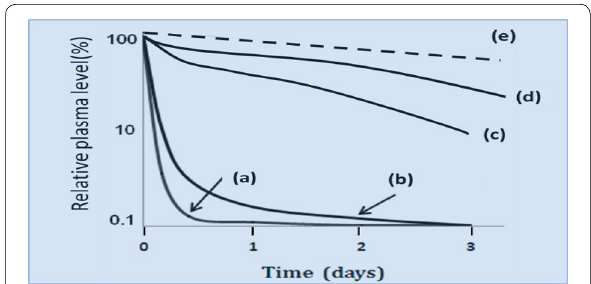
Fig. 2 Schematic representation of plasma concentration of different molecular size drugs [33, 34]: a low-MW free drugs (e.g., doxorubicin, DOX) and b–e their polymer complexes. The drug concentration in plasma after i.v. injection of low-MW drugs decreases rapidly